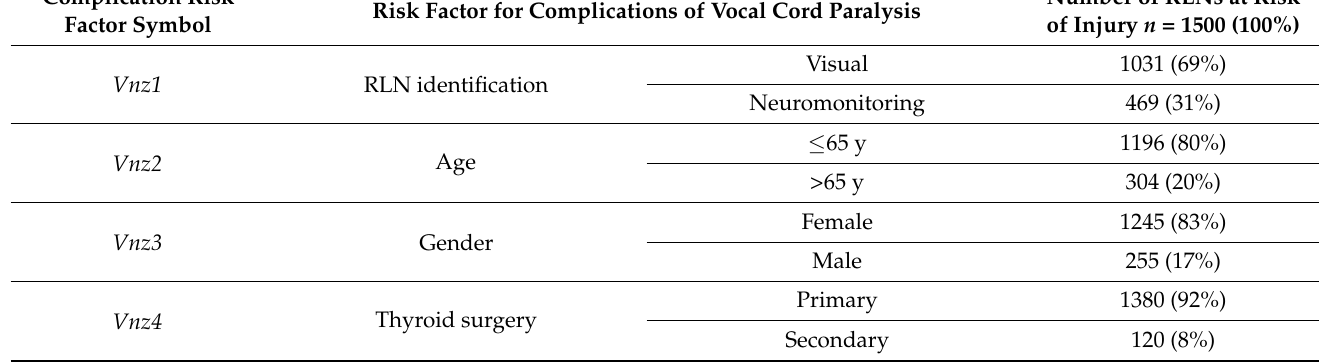
Table 2. Risk factors for complications of vocal cord paralysis and the number of RLNs at risk of